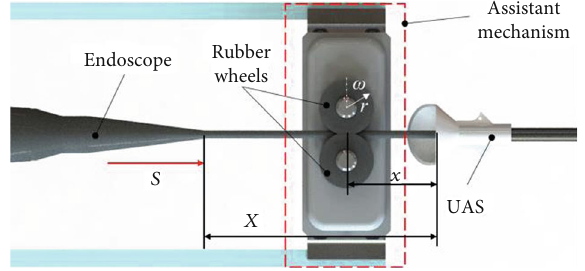
Figure 9: Design of the assistance mechanism for the insertion of the